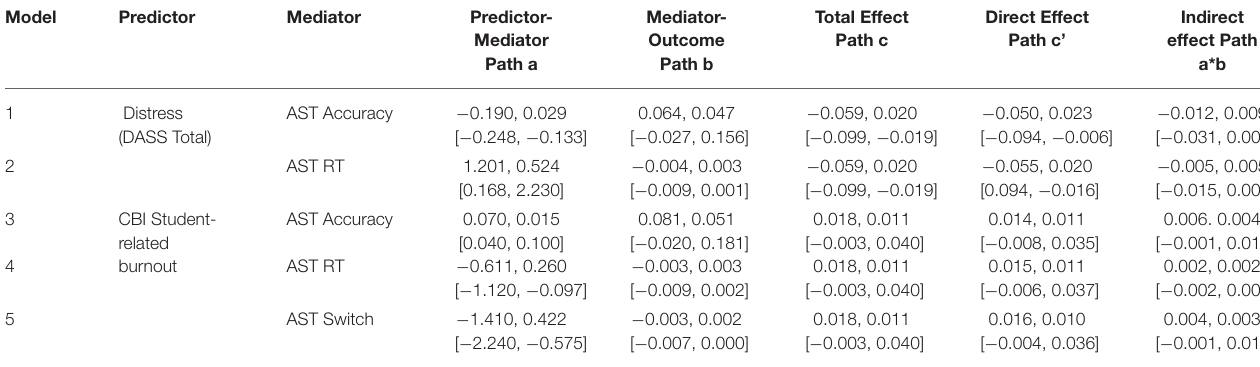
TABLE 5 | Unstandardised path estimates (ß) with Standard Errors and bootstrapped 95% lower- and upper-confidence intervals in brackets. Model